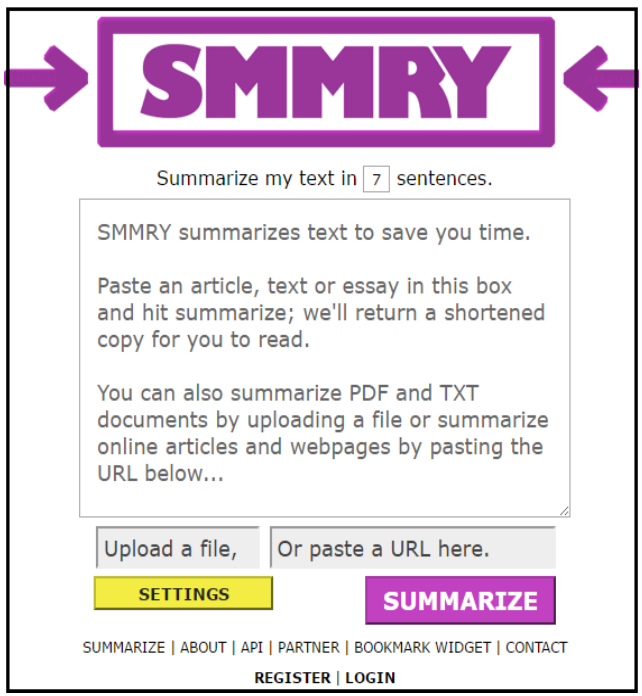
Figure 2. SMMRY tool.